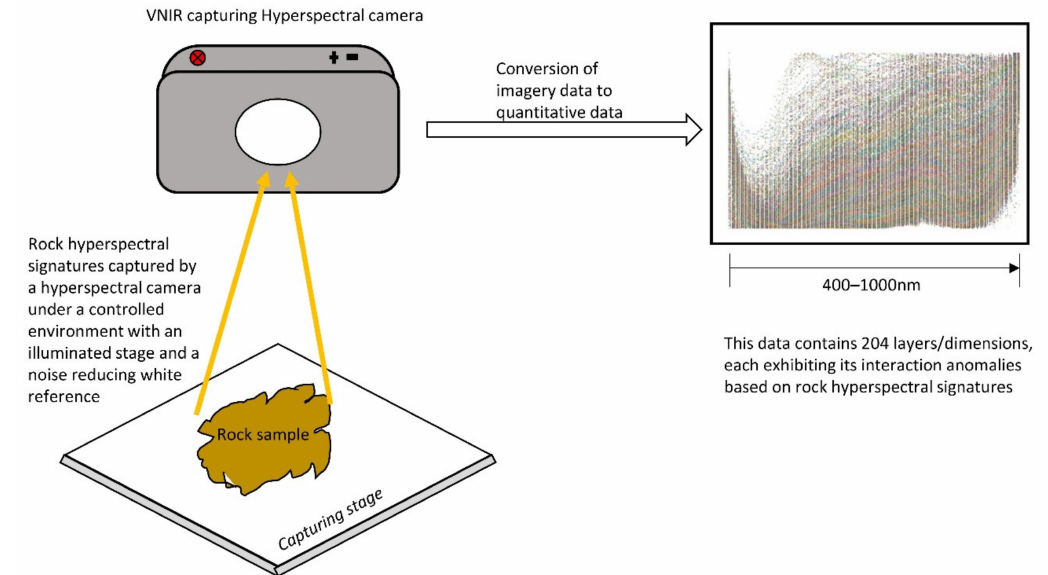
Figure 3. A hyperspectral signature capturing setup is used in collecting and building a rock and/or mineral spectral database. The curves are spectra in different spatial pixels of eight rock lithologies.